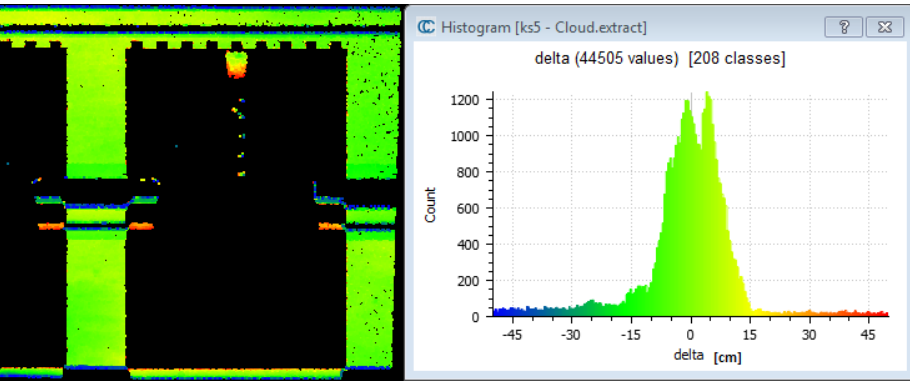
Fig. 3. Deviations from the theoretical